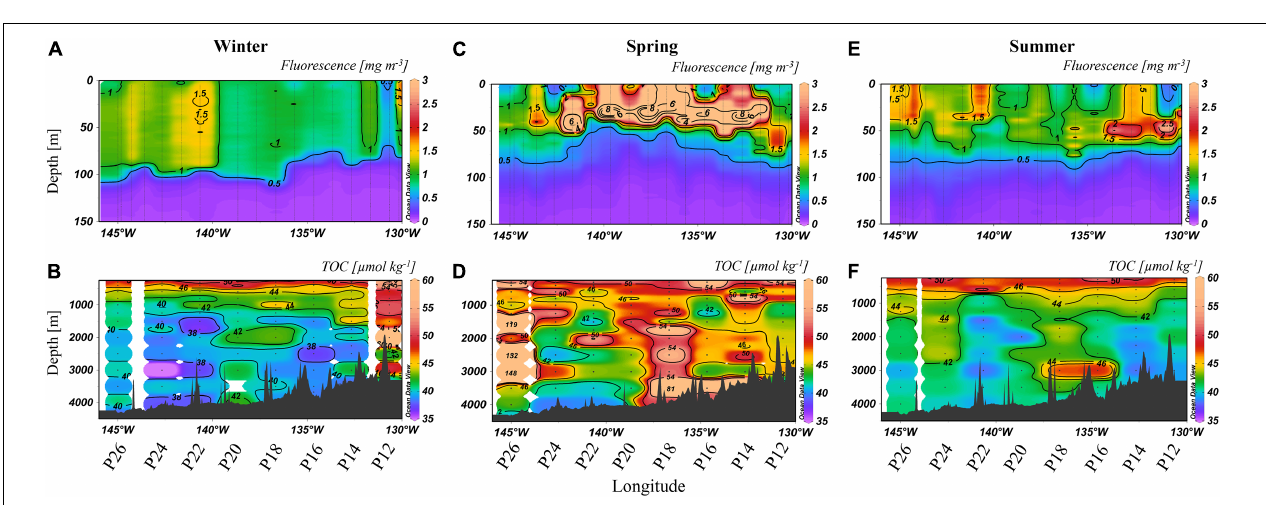
FIGURE 2 | Fluorescence to 150 m (A,C,E) [mg m − 3 ] and TOC [ µ mol kg − 1 ] at depths > 250 m (B,D,F) from 2017. The color scales are non-linear to better visualize small changes in concentrations in the deeper water column. Note that fluorescence was measured at all stations while TOC was determined at selected stations, as labeled below the x -axis.